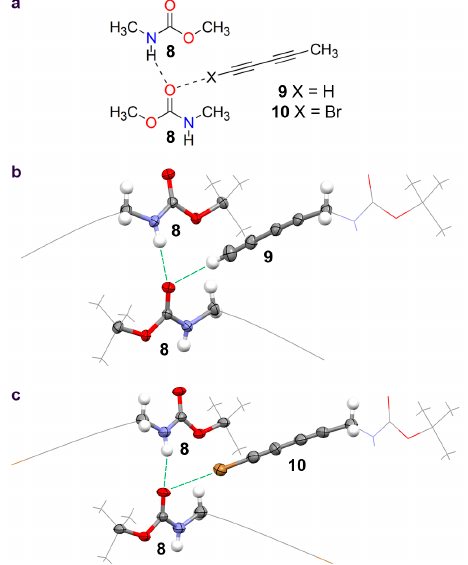
Figure 5. Summary of DFT calculations. ( a ) structures of systems 8 - 8 - 9 and 8 - 8 - 10 , in which 8 , 9 and 10 are N , O -dimethylcarbamate, penta-1,3-diyne and 1-bromopenta-1,3-diyne. Initial geometries for systems ( b ) 8 - 8 - 9 extracted from the crystal of 1 and ( c ) 8 - 8 - 10 corresponding to the crystal of 2 .